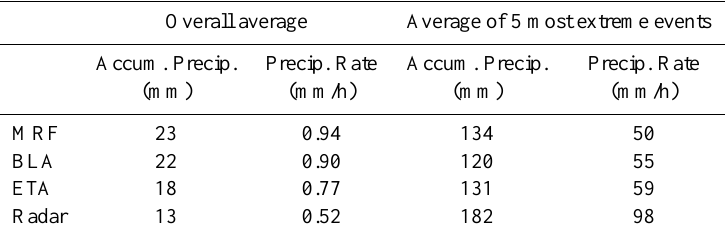
Table 1. Statistical summary of the quantitative precipitation distribution produced by the numerical simulation and recorded by the radar data for 14 September 1999.